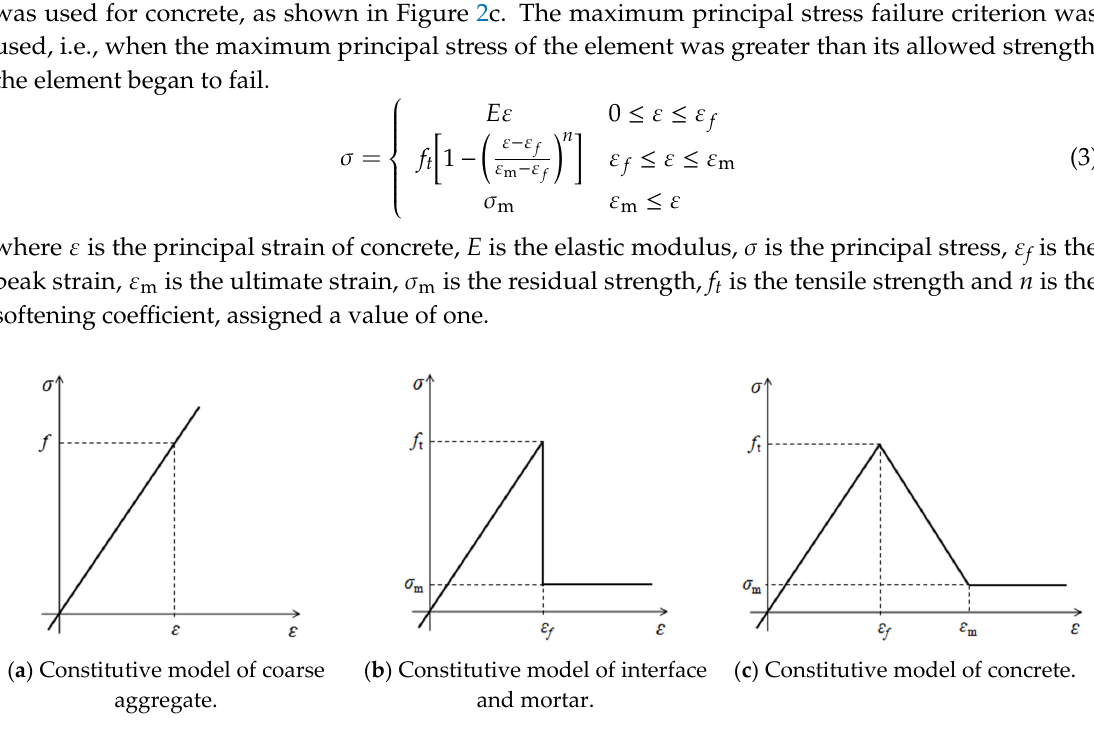
Figure 2. Constitutive relationships among components.